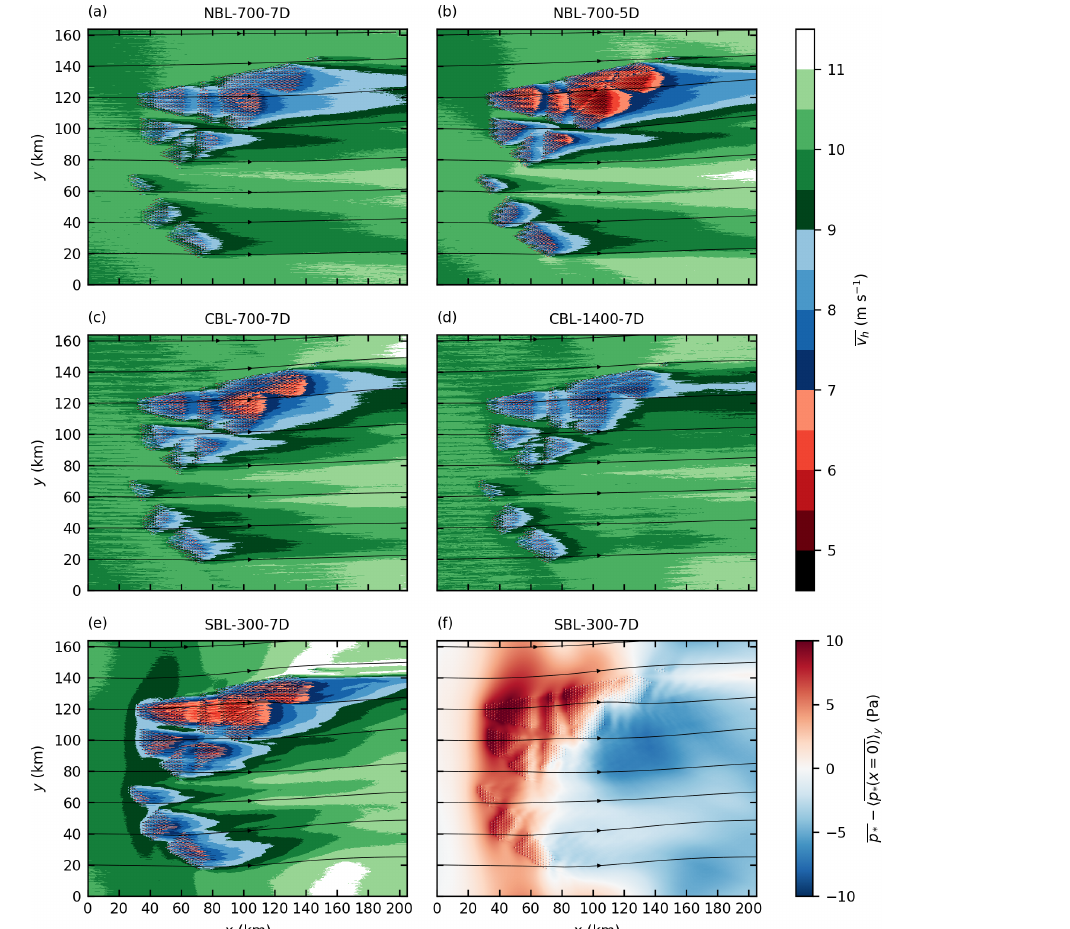
Figure 4. Mean horizontal wind speed v h at hub height for all five cases (a–e) and perturbation pressure p ∗ at hub height relative to its value at the inflow for the case SBL-300-7D (f) . Streamlines indicate the wind